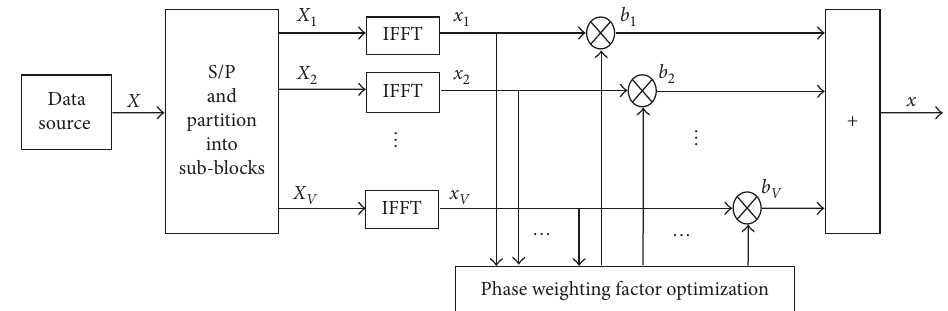
Figure 1: Block diagram of PTS